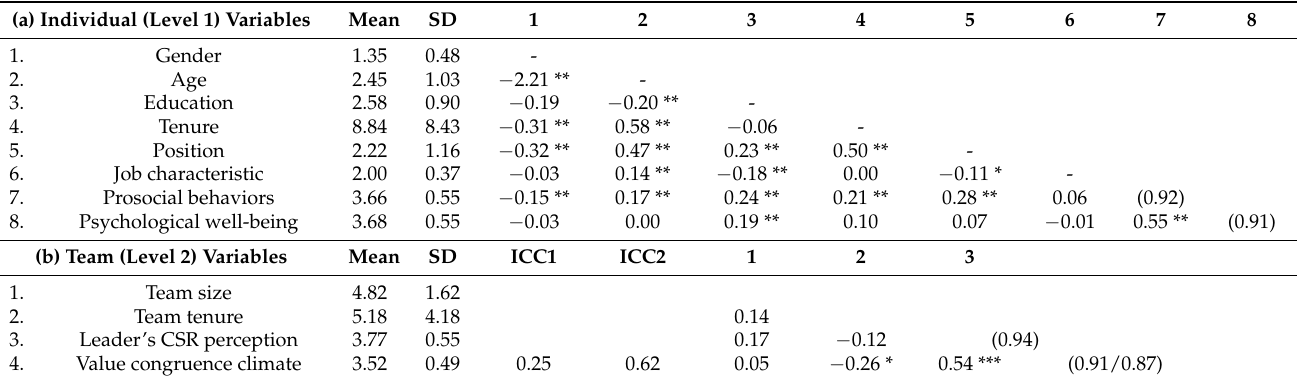
Table 1. Descriptive statistics and